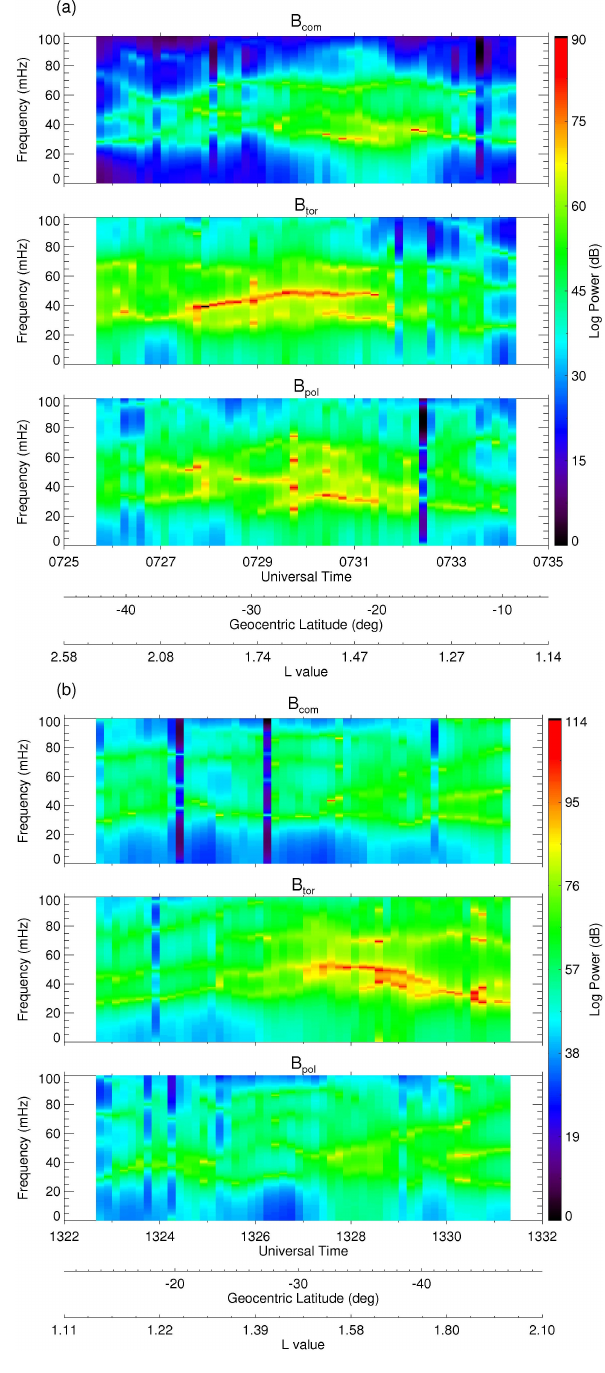
Fig. 5. MESA dynamic power spectra for magnetic components observed along the CHAMP trajectory on (a) 13 February 2002 and (b) 18 February 2003. Also shown are the geocentric latitude and L-shell for the satellite